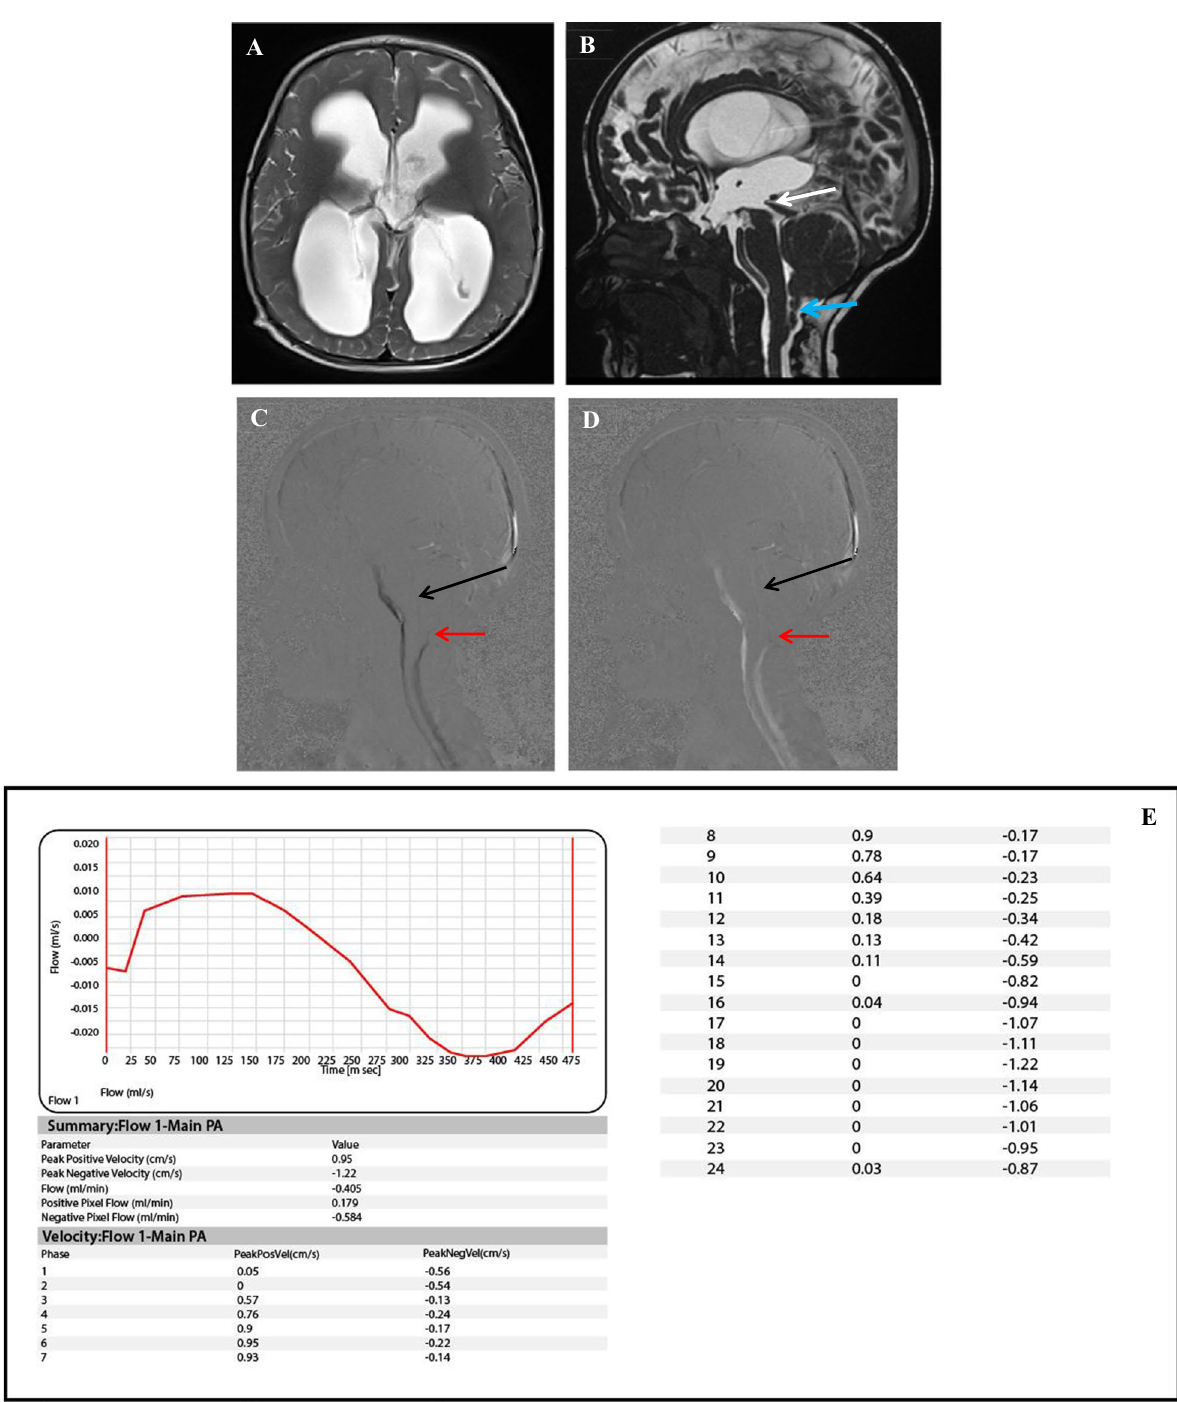
Fig. 2 A – E A 5‑year‑old male child with headache and blurred vision. A Axial T2W image shows moderate dilatation of supratentorial ventricles, B sagittal T2 DIVER image reveals caudal cerebellar tonsil herniation through foramen magnum (blue arrow), peaked tectum (white arrow), and narrowing of cerebral aqueduct of Sylvius, C , D sagittal phase‑contrast images reveal low CSF flow through the aqueduct at systole ( C ) and diastole ( D ) (black arrows), no CSF flow at posterior subarachnoid space (red arrows), and E velocity time curve‑ and CSF flow curve‑associated table reveals CSF in both diastole (above the base line) and systole (below the base line) with PSV: 1.2 cm/s, PDV: 0.9 cm/s, MV: 1.05 cm/s, MSF: 0.02 m/s, and SV: 5 µl (hypodynamic CSF circulation with low CSF velocities and stroke volume at aqueduct of Sylvius and no CSF flow at posterior subarachnoid space at the level of foramen magnum Arnold–Chiari